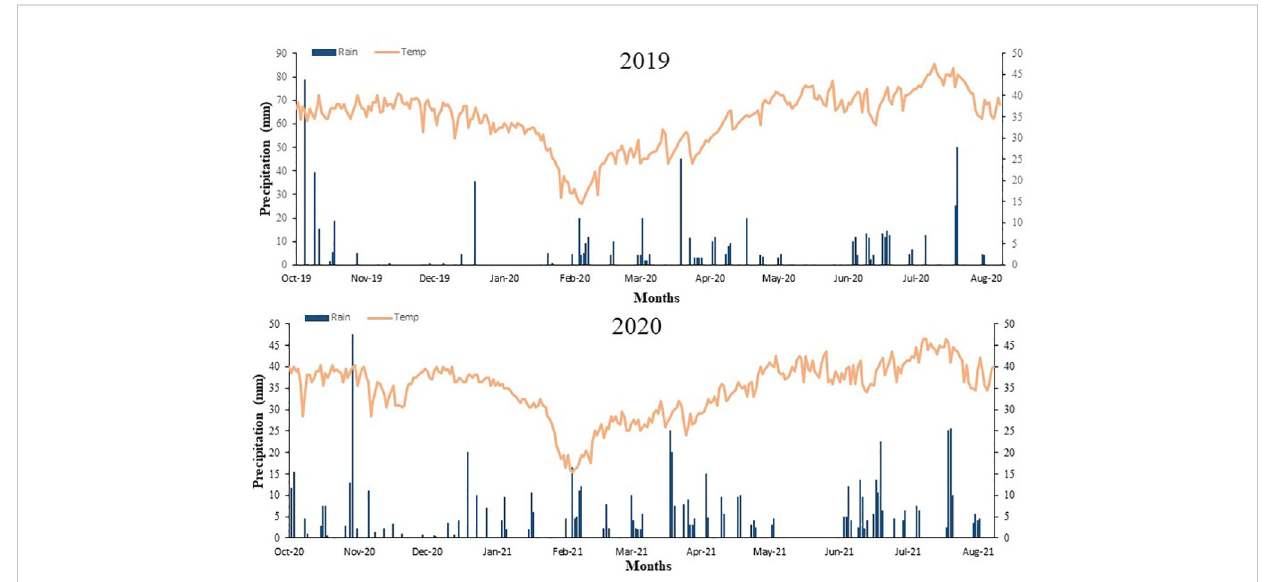
FIGURE 1 Daily weather data including the precipitation and average temperature during both experimental